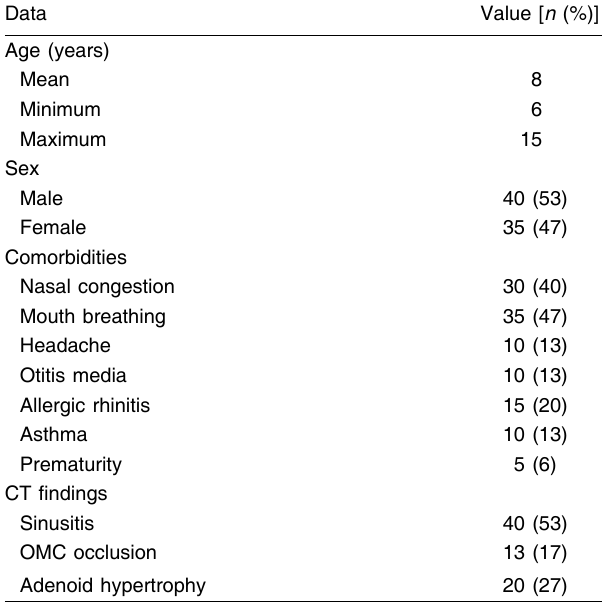
Table 1 Characteristics of enrolled